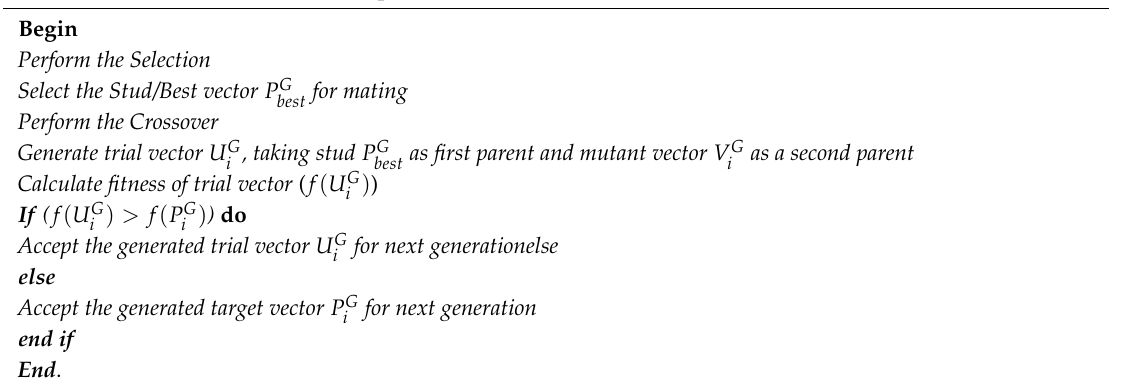
Algorithm 2: Stud Crossover (SC)